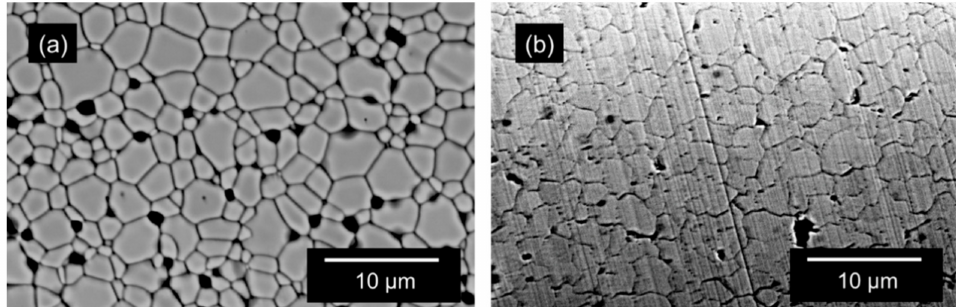
Figure 2. Scanning electron micrographs showing the microstructures of the ( a ) 10GDC control pellet sintered at 1600 ◦ C for 10 h and ( b ) sintered under 4% H 2 -N 2 at 1100 ◦ C for 20 h followed by re-oxidation. The black areas in the micrographs are porosity and thermally etched grain